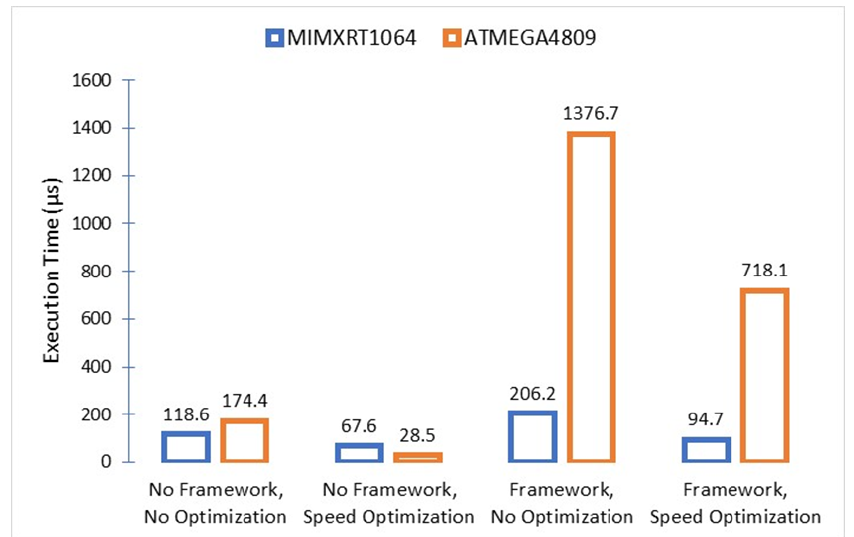
Figure 14. Peripheral configuration running time comparison for the 32-bit NXP microcontroller (MIMXRT1064) and for the 8-bit Microchip microcontroller (ATMEGA4809) considering the four evaluated